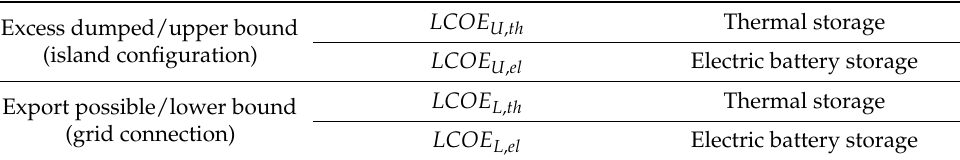
Table 4. A summary of the different cost parameters computed in this study.